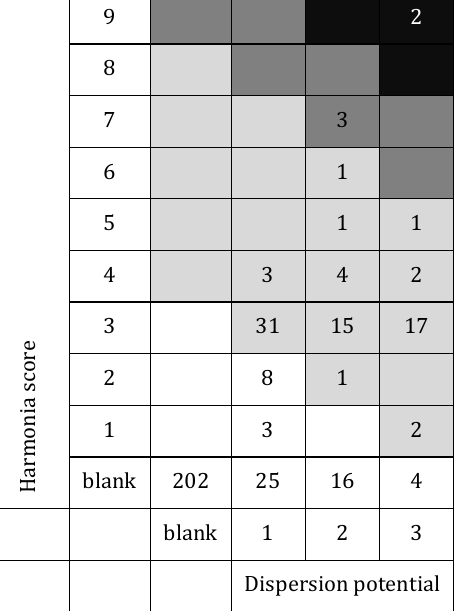
Table 4. The distribution of species by ‘Total sum of impacts’ and ‘Dispersion potential’ (n=2079). The ‘Total sum of impacts’ are the sum of scores from ‘Adverse impact on native species’, ‘Alteration of ecosystem functions’, ‘Economical effect’ and ‘Public health effects’. Blank was used when no information could be retrieved. Species receiving 14 points or more in